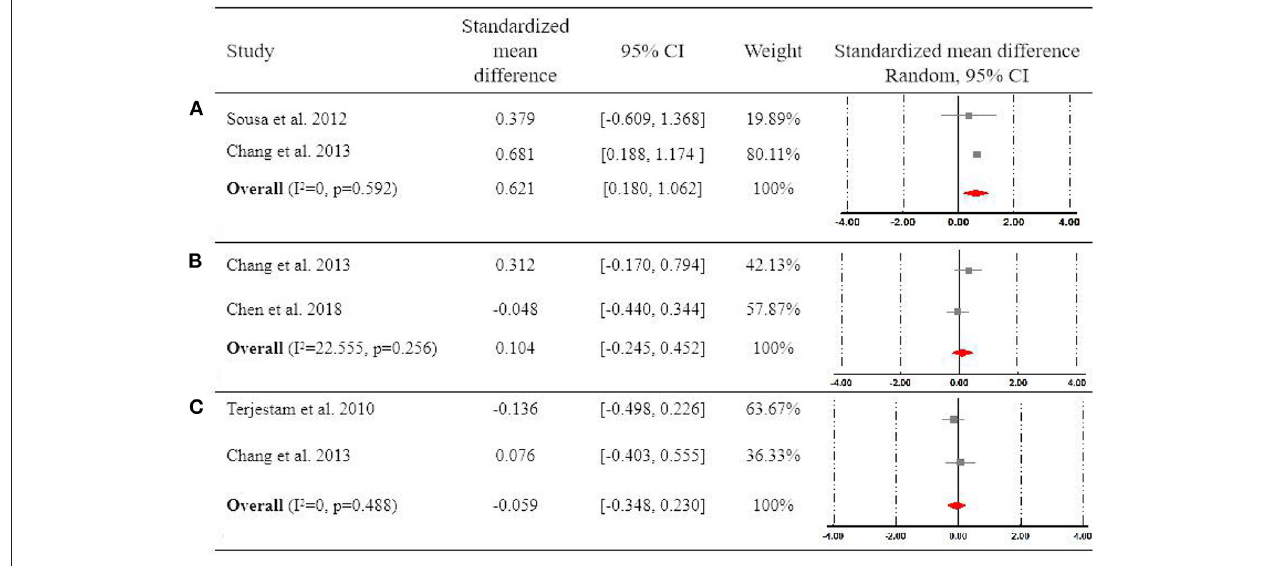
(i.e., depression, anxiety), biomarkers of stress response